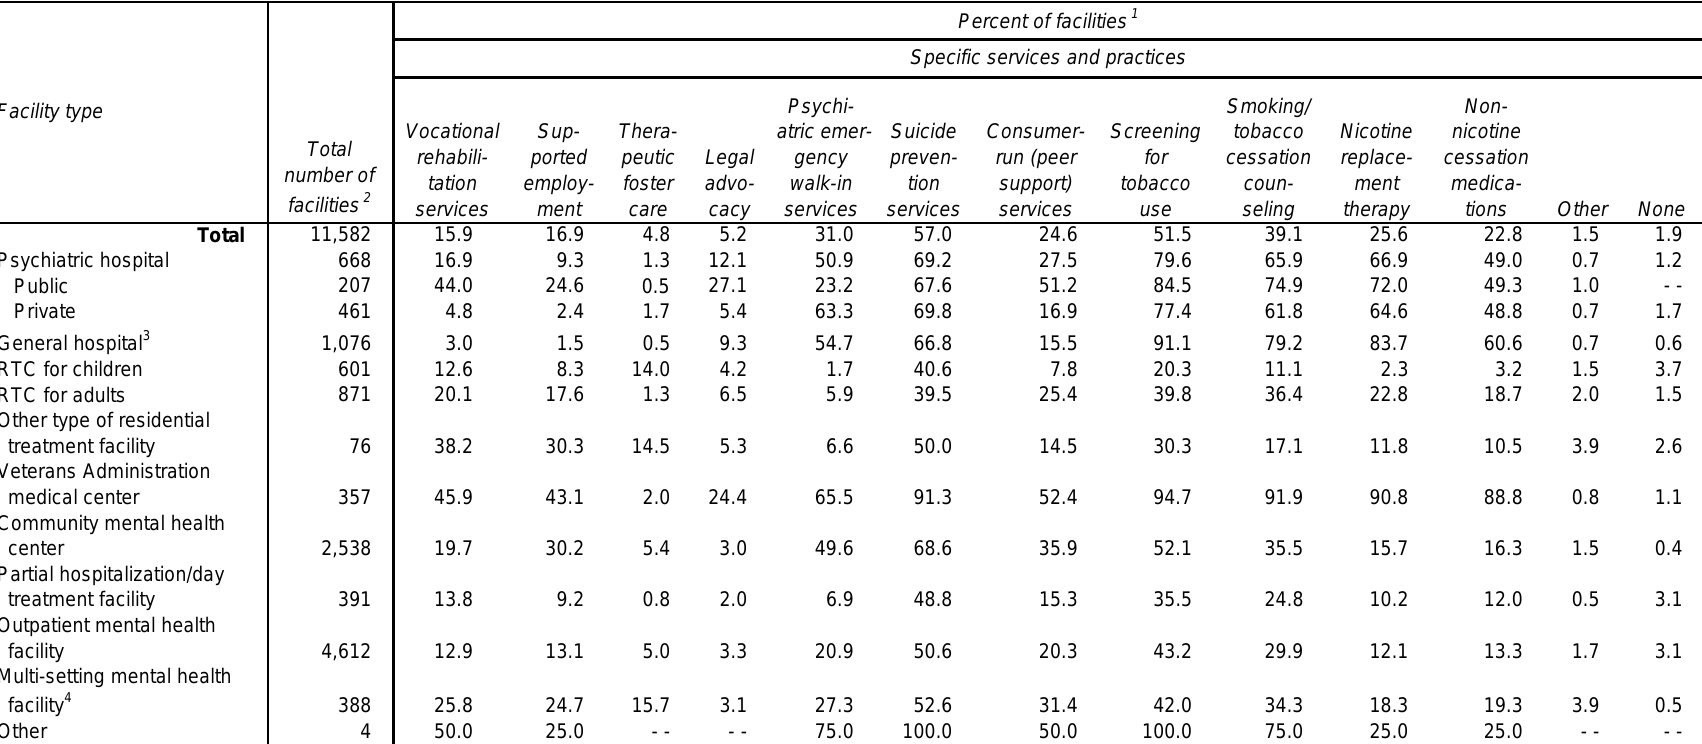
Table 2.4b. Mental health treatment facilities offering specific services and practices, by facility type: Percent, 2017